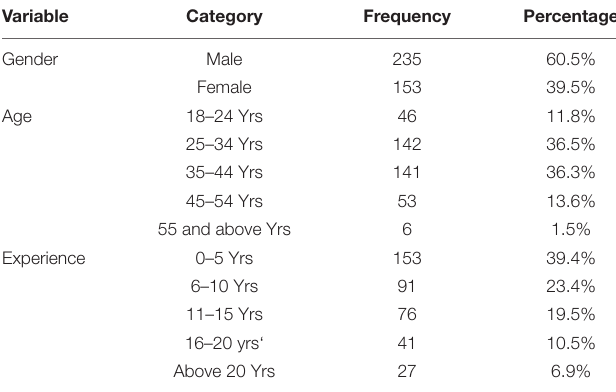
TABLE 1 | Demographic description of